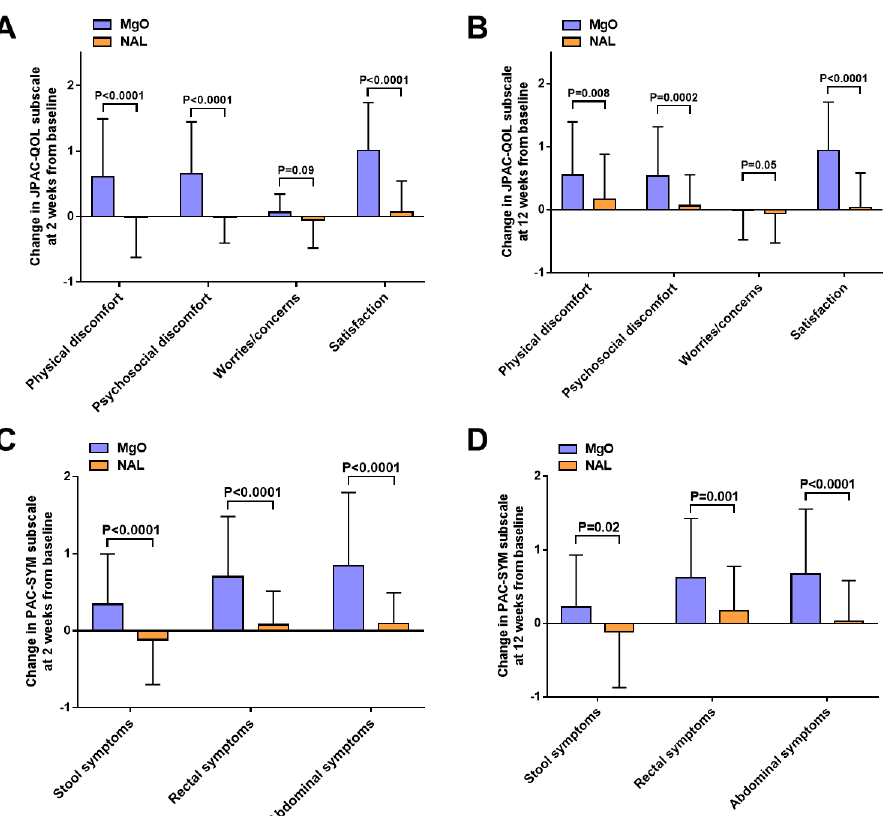
Figure 3. ( A ) Change in the number of spontaneous bowel movements (SBMs; times/week) from baseline to 2 and 12 weeks (after treatment) in the magnesium oxide group and the naldemedine group; and ( B ) change in the number of complete spontaneous bowel movements (CSBMs; times/week) from baseline to 2 and 12 weeks (after treatment) in the magnesium oxide group and the naldemedine group.